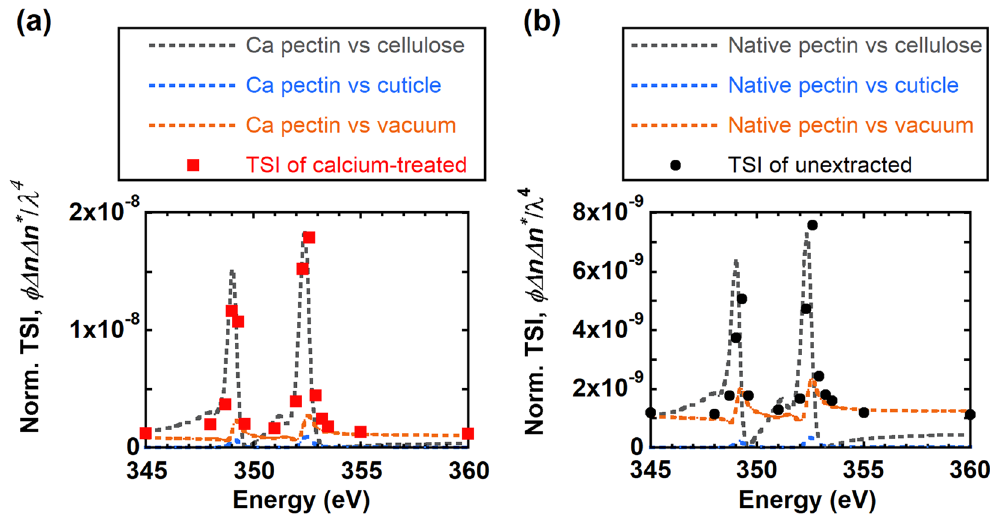
Figure 6. Comparison of TSI (points) of ( a ) calcium-treated and ( b ) unextracted epidermal cell wall to the product of volume fraction and scattering contrast (dotted lines) from different cell wall components near the calcium L-edge. TSI is normalized to the same value for both ( a , b ). Volume fraction φ is proportional to the thickness of the layer where contrast